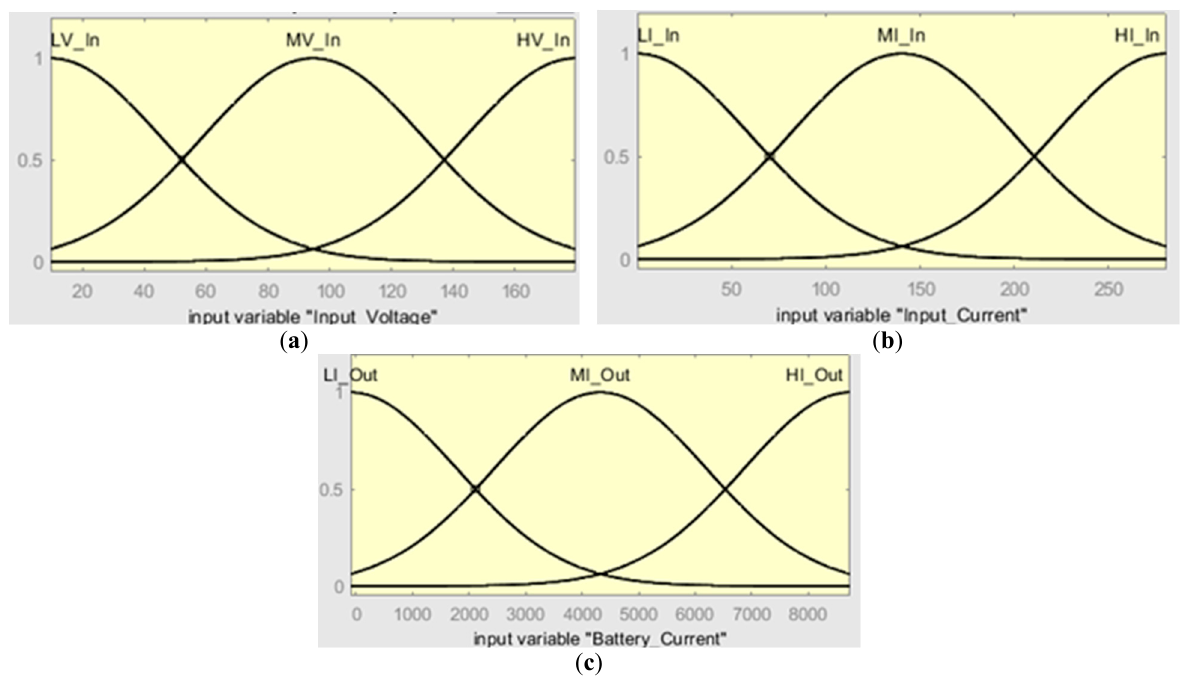
Figure 29. Pictorial representation of the FIS generated for MIMO system.